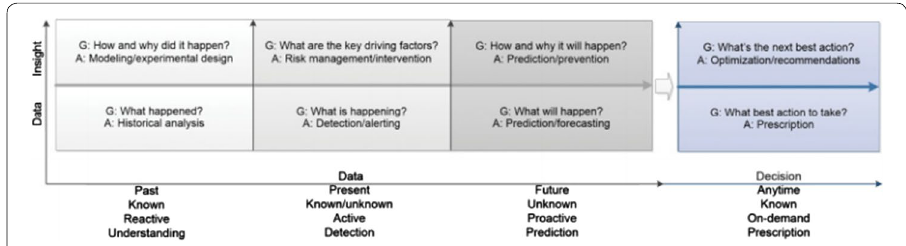
Fig. 2 Data-to-insight-to-decision analytic stages in data science